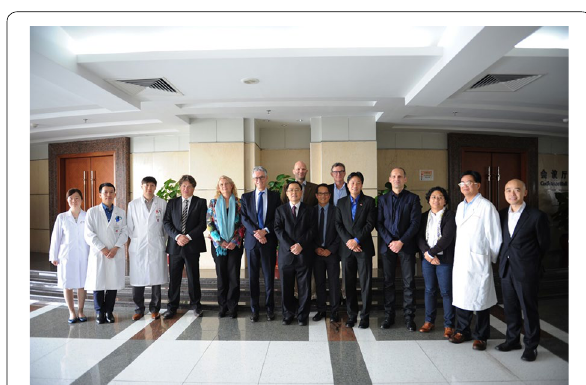
Fig. 2 Some of the speakers at the first Sino-Dutch Symposium on Oncology. From left to right: Dr. Shuang Liao, Dr. Yu-Jia Zhu, Prof. Zhen-Ffeng Zhang, Prof. Jean-Phille Pignol, Prof. Marion de Jong, Prof. Jaap Verweij, Prof. Chao-Nan (Miles) Qian ( in the front ), Prof. Timo ten Hagen ( in the back ), Prof. Jose Hardillo, Prof. Clemens Löwik, Mr. Raoul Tan, Prof. Reno Debets, Mrs. Gonny Pasaribu, Prof. Li-Wu Fu, and Mr. Jingmin Kan (Assistant Counsellor for Science and Technology at Embassy of the Kingdom of the Netherlands in